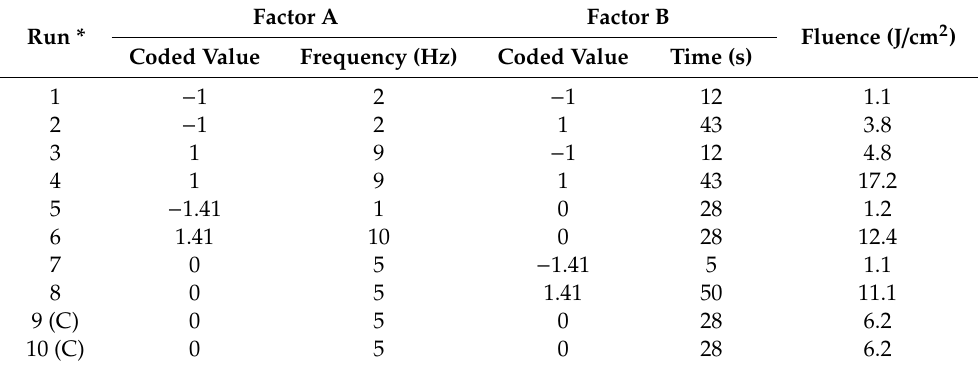
Fluence (J / cm 2 ) Fluence (J/cm 2 )